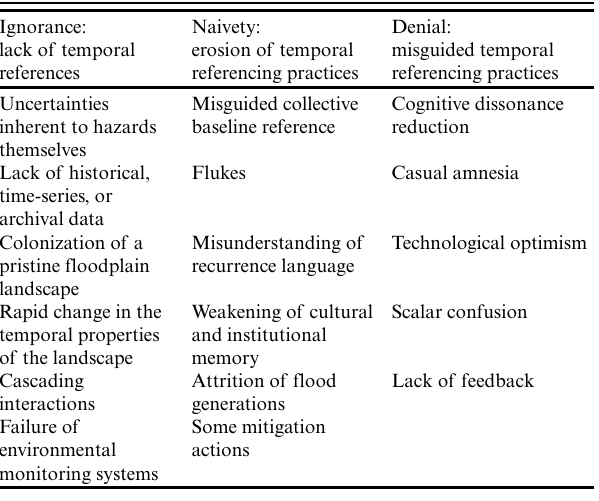
Table 1 . Mechanisms influencing collective surprise